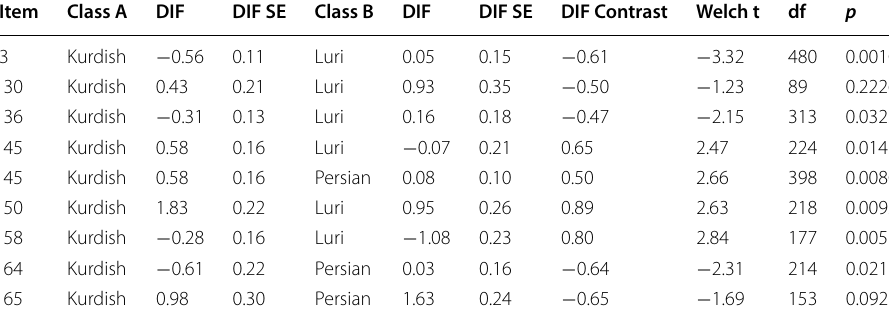
Table 10 Results of uniform DIF analysis of items (IUUESEE 2018)